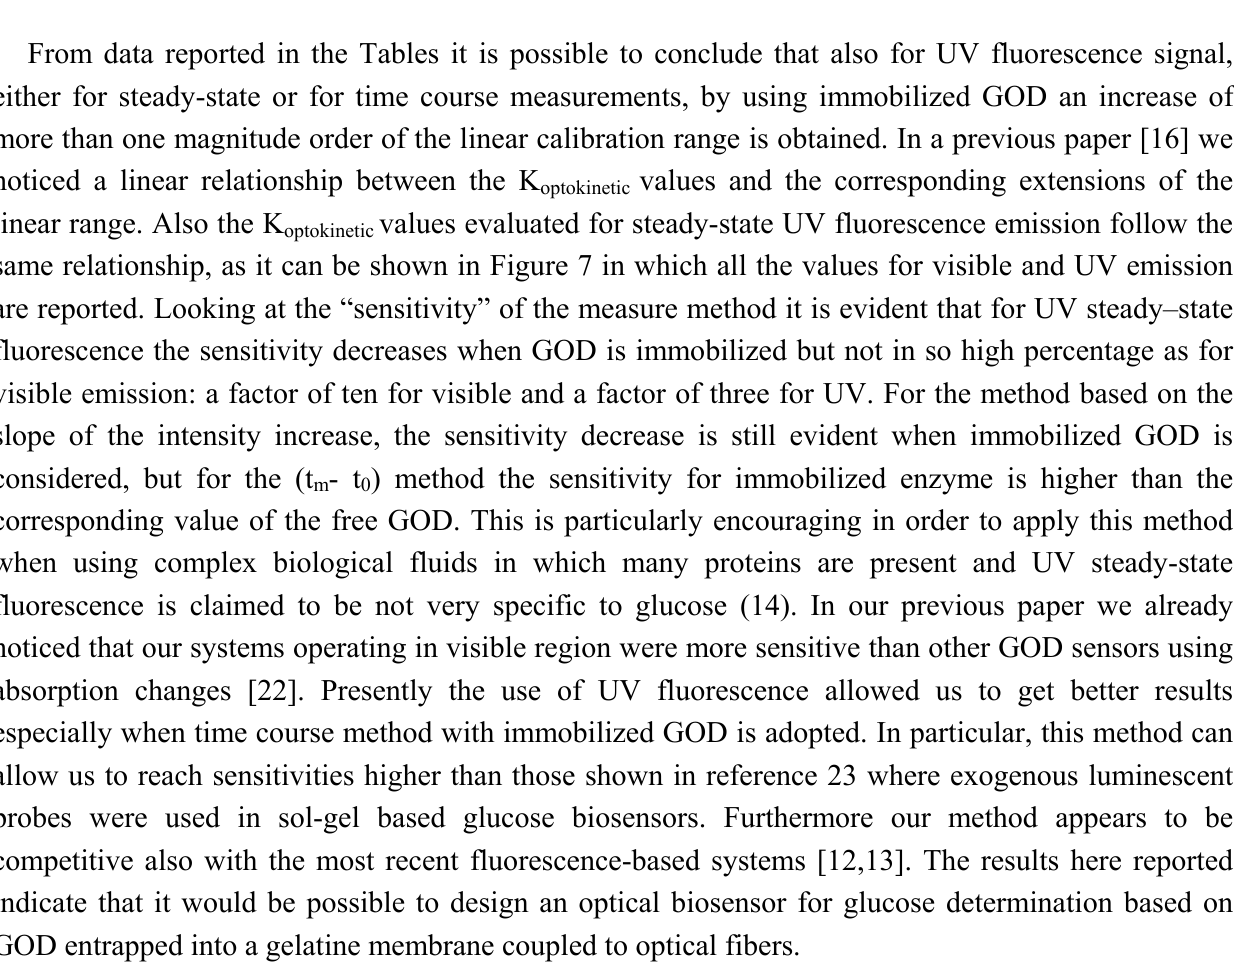
– t ) values as a function of ln([G]/([G] - m 0 ])) at different glucose 2([O 2